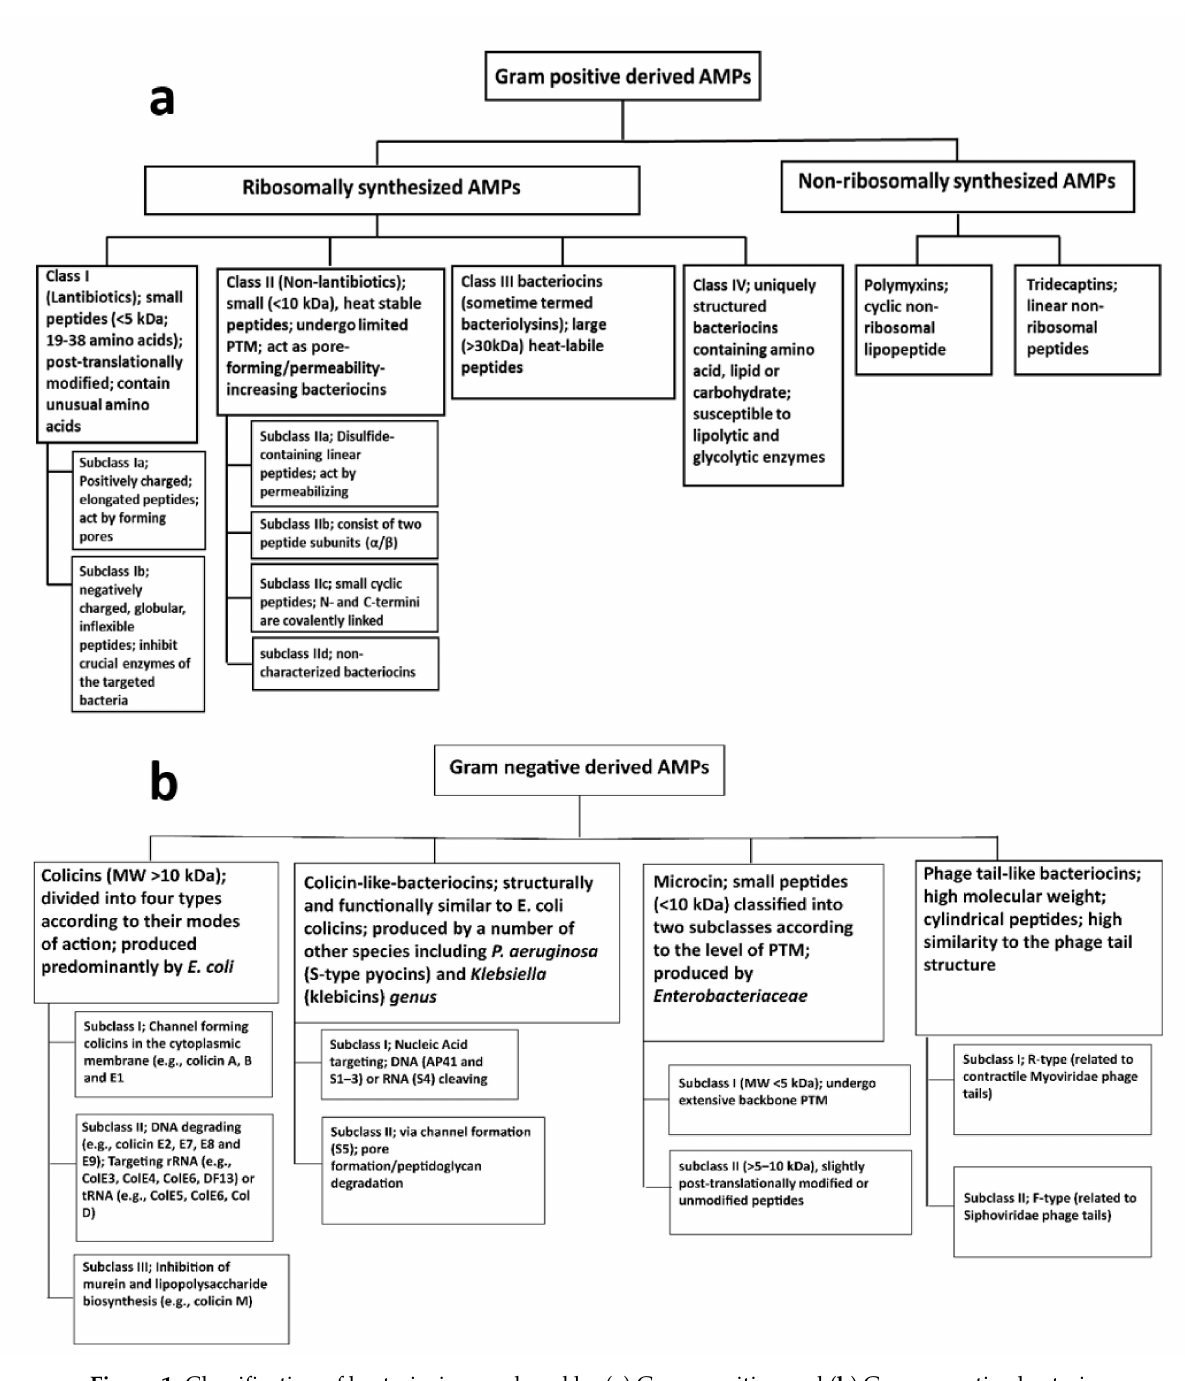
Figure 1. Classification of bacteriocins produced by ( a ) Gram-positive and ( b ) Gram-negative